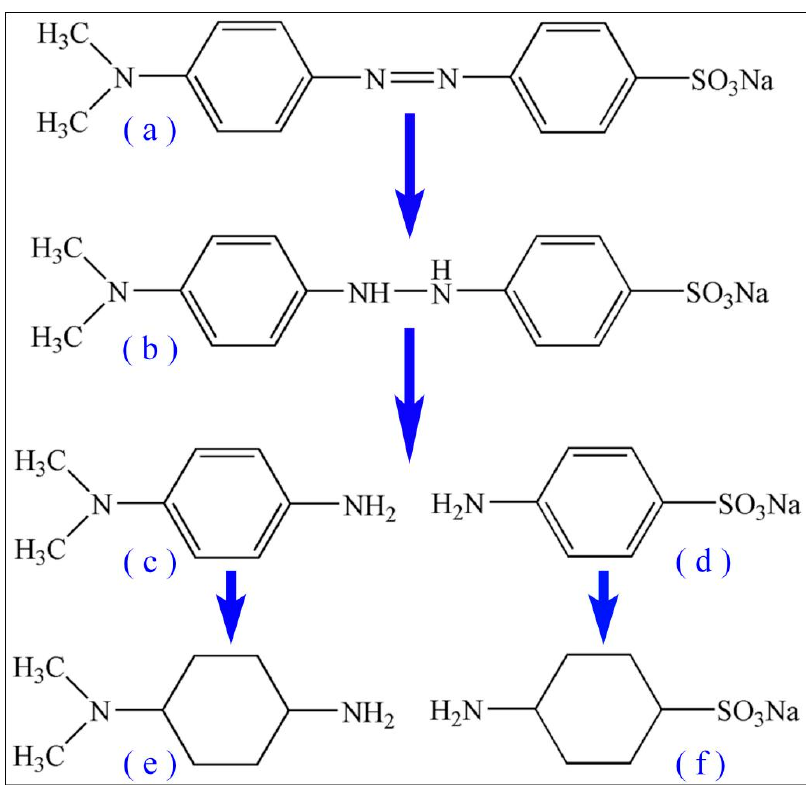
Figure 15. Schematic illustration of the possible intermediates produced in the photocatalytic degradation of methyl orange by ZnWO 4 nanoplates: ( a ) an original methyl orange molecule; ( b ) the methyl orange molecule when its azo-linkage is partially broken; ( c , d ) fragments of the methyl orange molecule when its azo-linkage is completely broken; ( e ) fragment ( c ) when the conjugation in the aromatic ring is destroyed; ( f ) fragment ( d ) when the conjugation in the aromatic ring is destroyed.